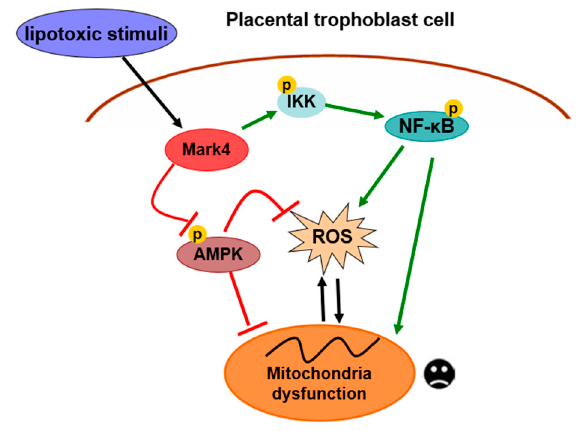
Figure 7. A proposed model for role of MARK4 in the regulation of oxidative stress and mitochondrial dysfunction in pig placental trophoblast cells. MARK4 promotes oxidative stress and mitochondrial dysfunction via activating IKK α /NF- κ B and inhibiting AMPK signaling pathways. Ar- rows indicates a positive regulation and bar-headed lines show negative regulation. Interactions depicted are based on studies performed in various tissues (in some cases placenta) and have been previously published. ROS: reactive oxygen species; P: phosphorylation.